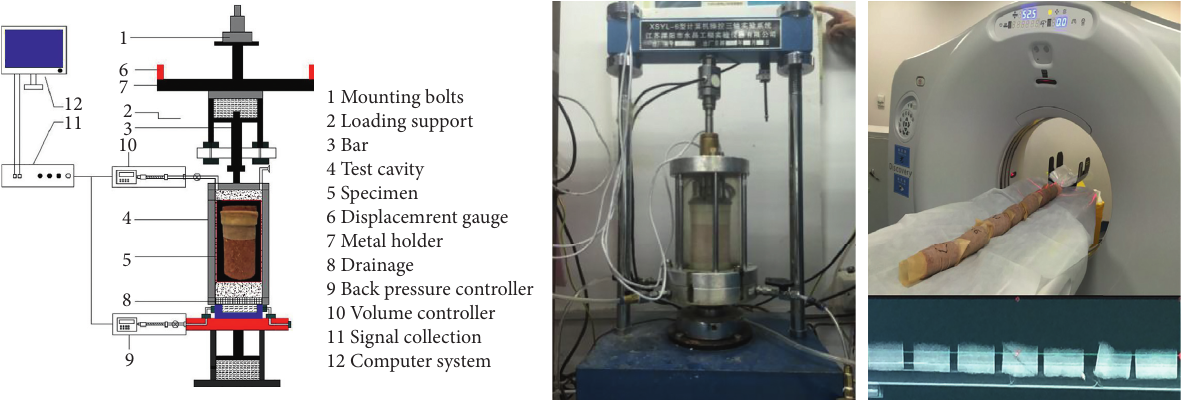
Figure 2: Laboratory apparatus used in the triaxial tests and microscopic scanning experiment.